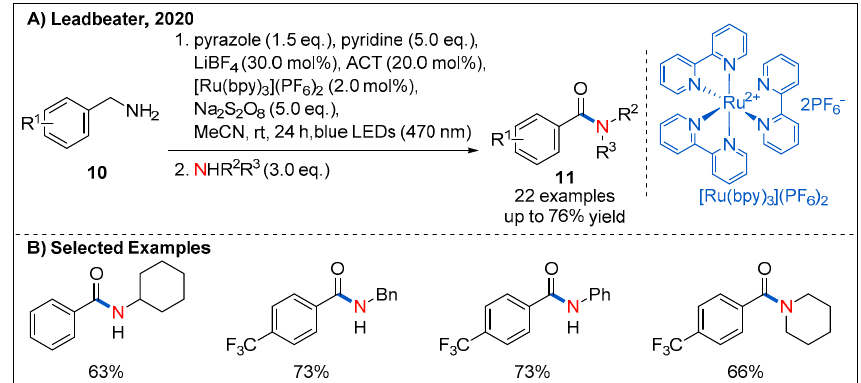
Figure 5. Oxidative amidation of x’alcohols.